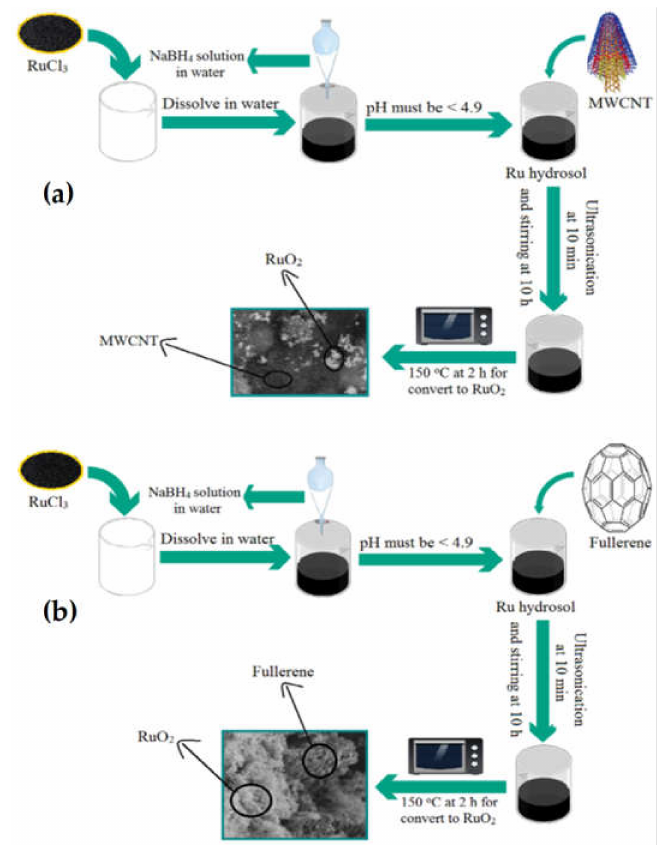
Figure 15. Schematic representation of the synthesis of the ( a ) RuO 2 /MWCNT and ( b ) RuO 2 / fullerene nanocomposites. Reproduced with permission from [220]. Energy Storage,